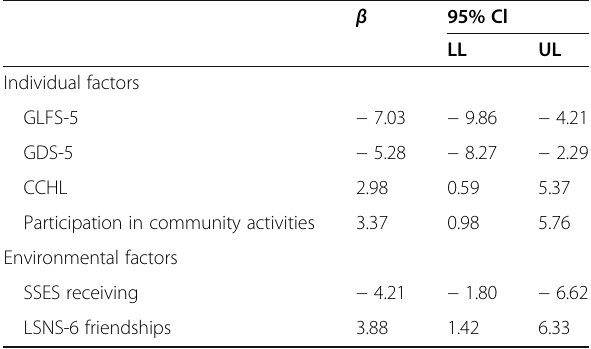
Table 4 Demographic, individual, and environmental factors associated with life-space mobility in generalized liner model